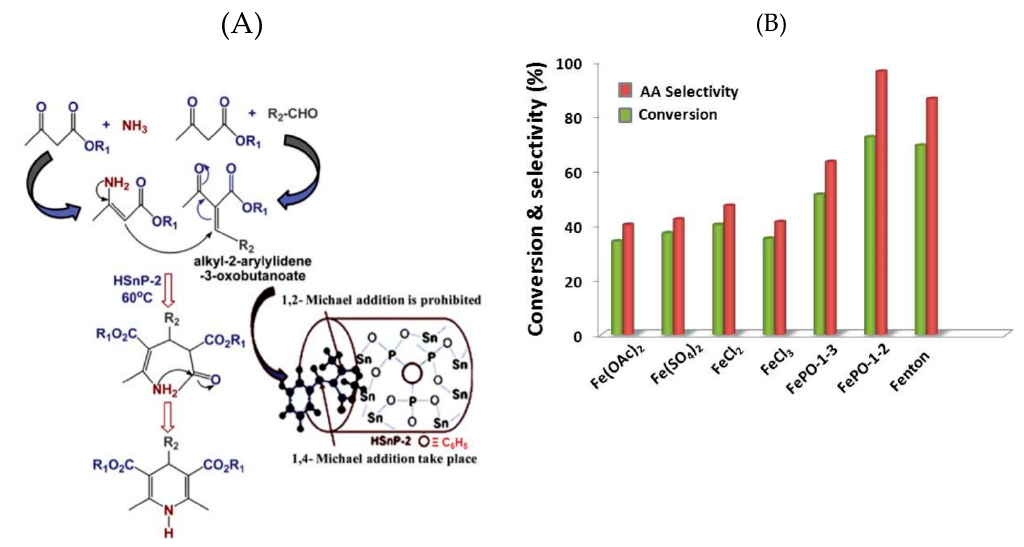
Figure 9. ( A )—probable reaction mechanism and the role of the HSnP-2 catalyst in selective synthesis of 1,4-dihydropyridines. Reprinted with permission from [117]. Copyright (2013), The Royal Society of Chemistry and ( B )—dependence of the product yield on various catalysts for the aerobic oxidation of cyclohexanone at 75 °C. Reprinted with permission from [120]. Copyright (2016), American Chemical Society. Table 2. Summary of the porous metal phosphonates for catalytic